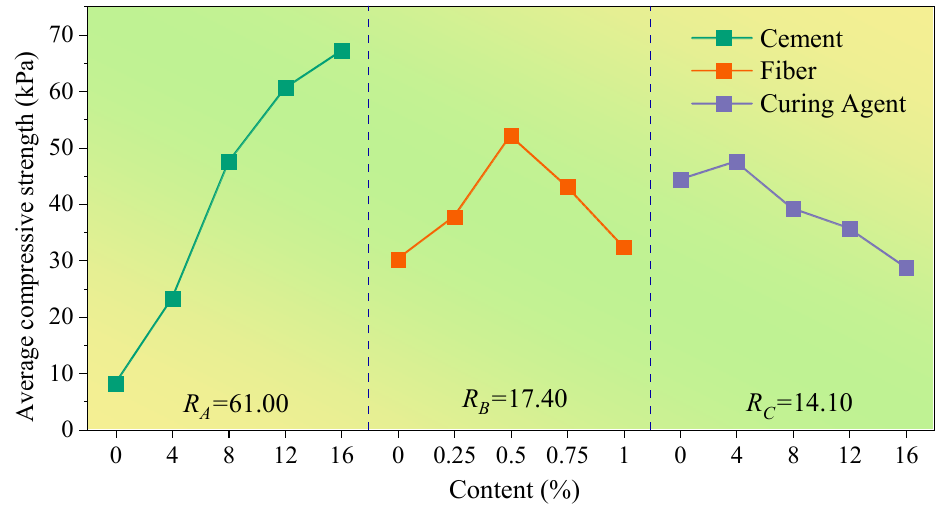
Figure 8. The influence of various factors on the compressive strength. Notes : R A, R B and R C represent the extreme difference of each strength index under different contents of cement, fiber and curing agent, respectively.